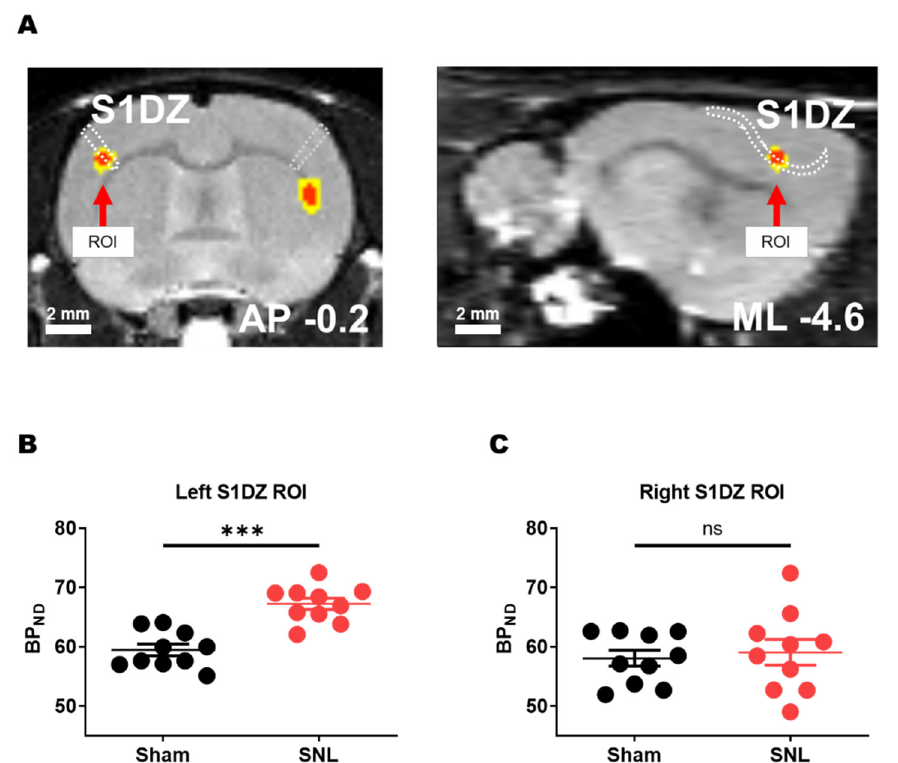
Figure 1. The SNL group showed an increased mGluR5 level in the S1DZ contralateral to the peripheral nerve injury. ( A ) Result images of a voxel-by-voxel two-sample t -test comparison between PET images of the SNL and sham group (SNL > sham). Significance maps of uncorrected p < 0.001 (red) or p < 0.005 (yellow) overlaid on a single MRI template are shown with coronal and sagittal section images of appropriate coordinates. The S1DZ areas are drawn with a white dotted line. ( B ) mGluR5 availability levels in the left S1DZ ROI were higher in rats subjected to right L5 SNL surgery compared with that in sham group rats (*** p < 0.001; two-sample t -test; sham = 59.45 ± 0.99, n = 10; SNL = 67.22 ± 0.96, n = 10). ( C ) mGluR5 levels in the right S1DZ ROI did not differ between groups (ns: not significant; two-sample t -test; sham = 58.03 ± 1.36, n = 10; SNL = 59.03 ± 2.18, n = 10).